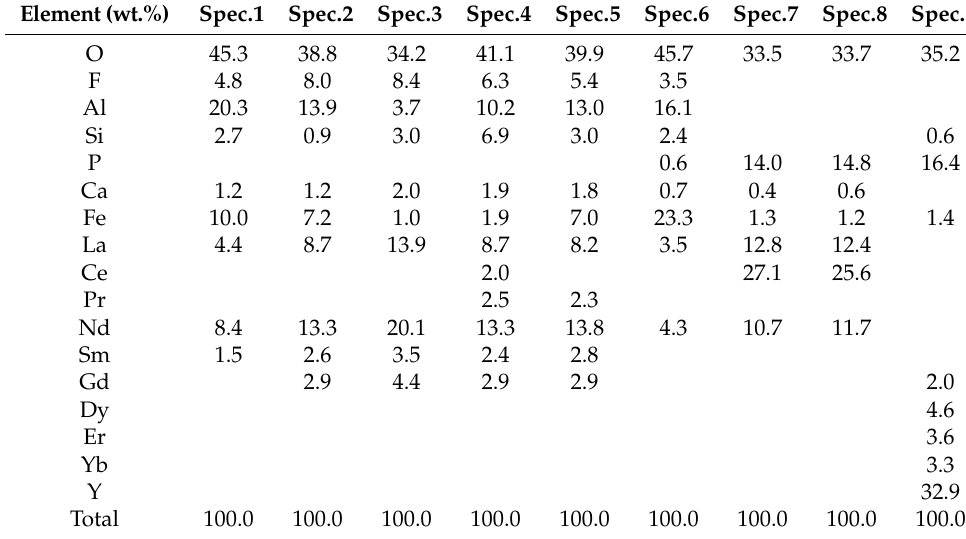
Table 7. Results of chemical analysis of points (sample 180, Figure 11). Element (wt.%)